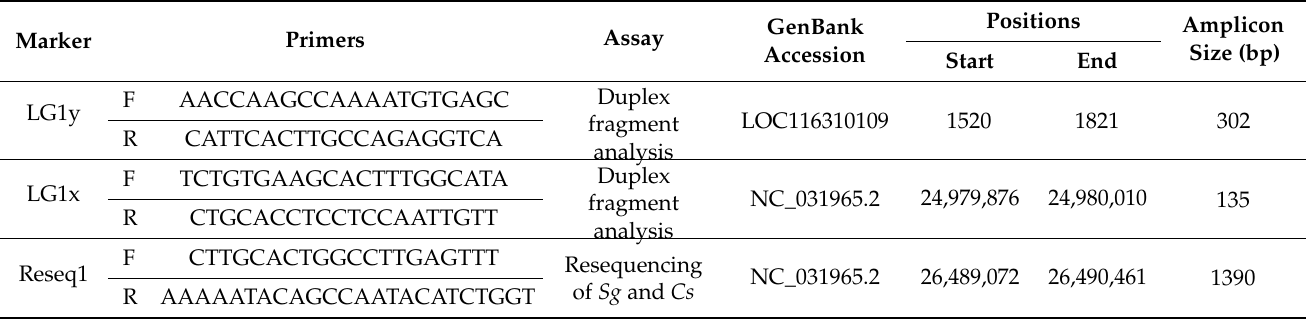
Table 3. Polymerase chain reaction (PCR) primers for generation of amplicons for fragment analysis and resequencing of the figla-like gene in S. galilaeus ( Sg ) and the Chitralada strain ( Cs